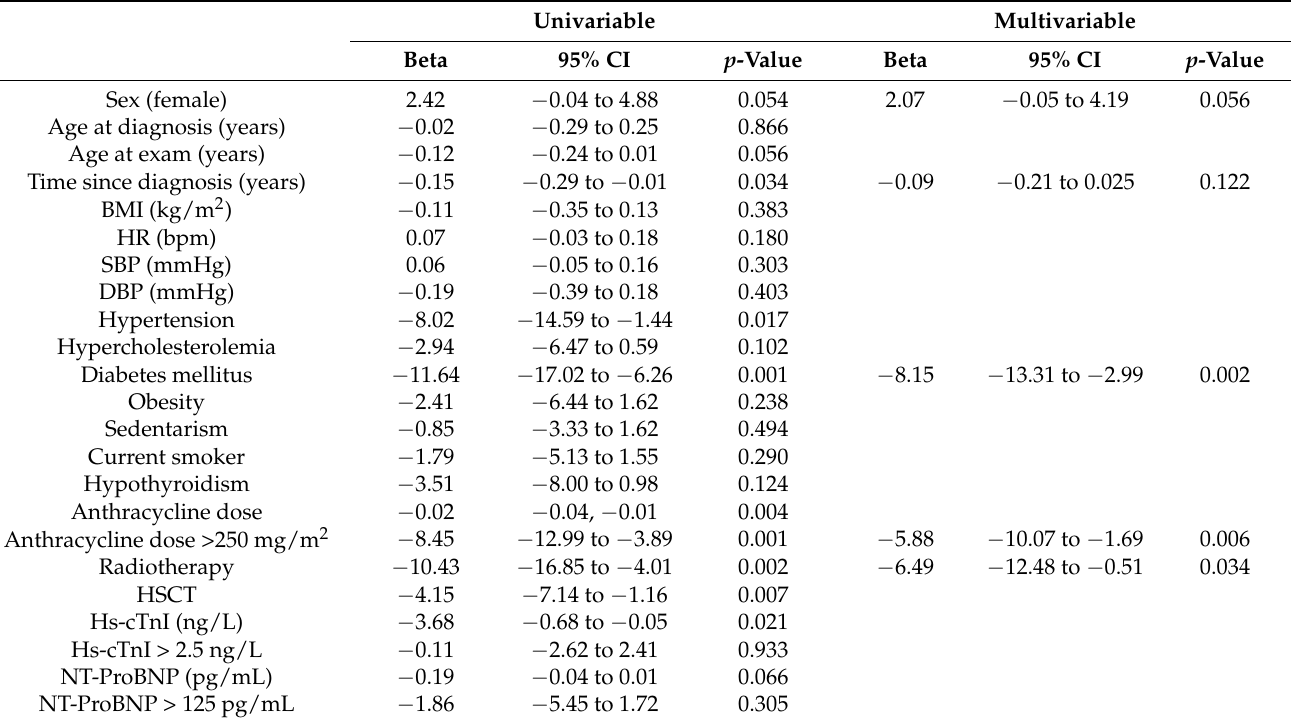
Table 3. Univariable and multivariable linear regression models for LVEF in survivors. Univariable Multivariable